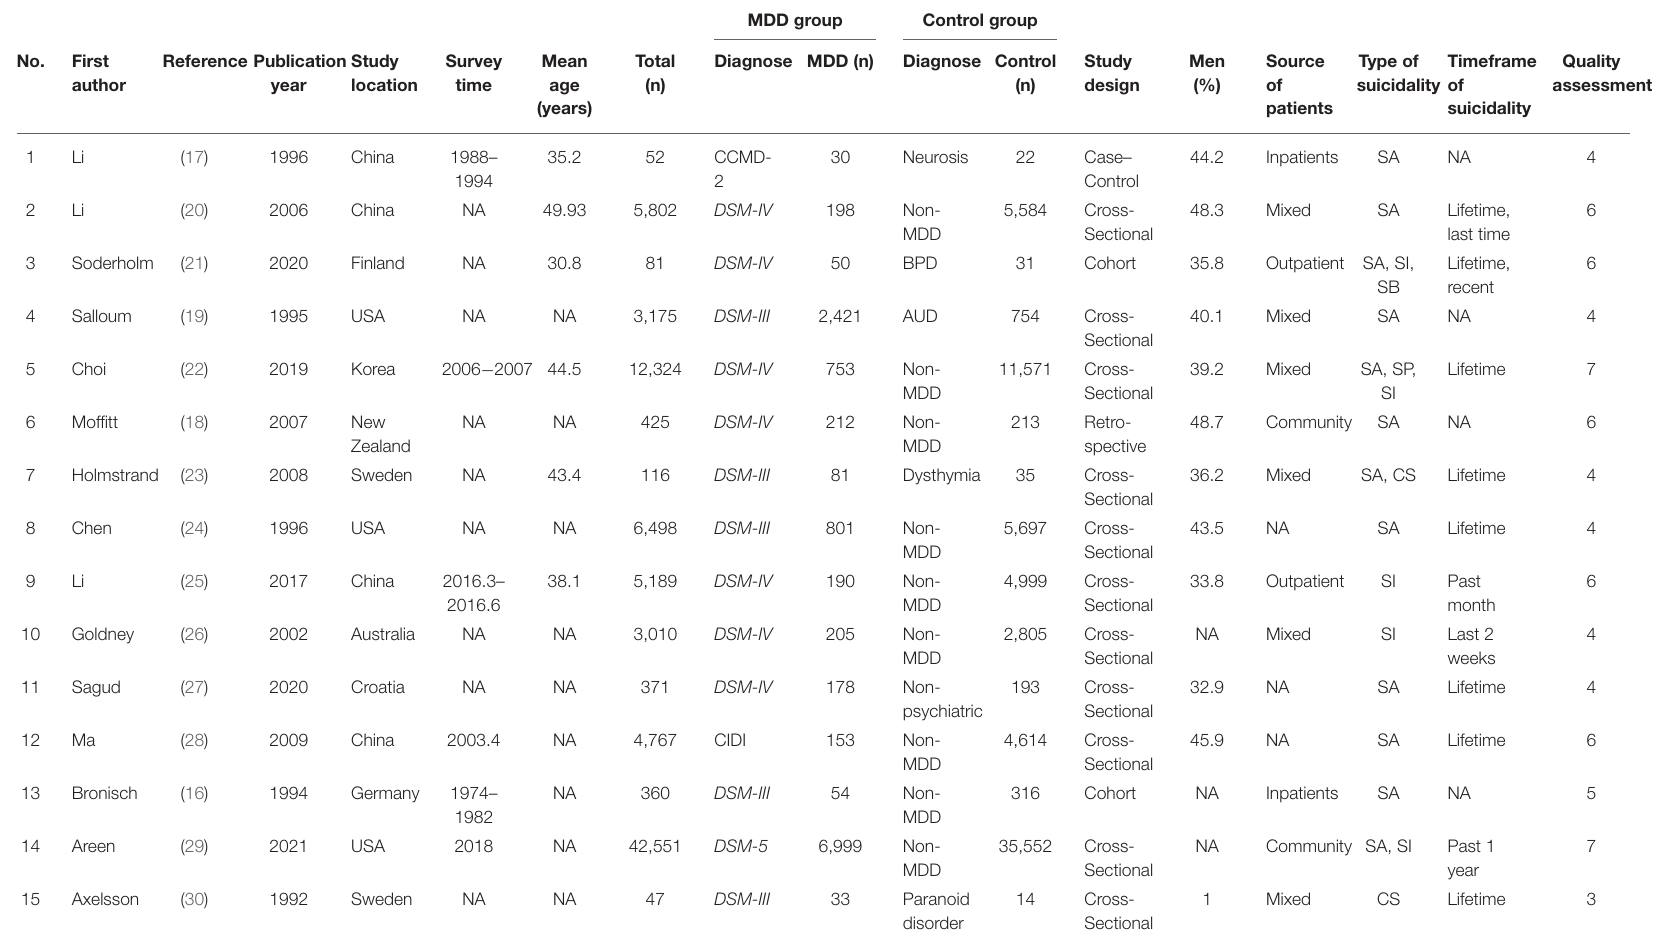
TABLE 1 | Characteristics of the studies included in the